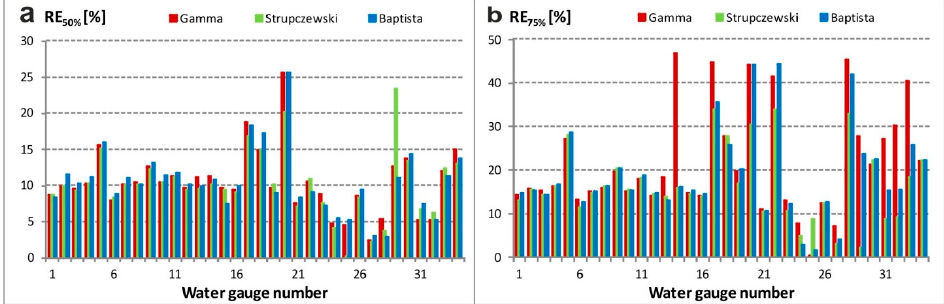
Figure 6. Relative errors of hydrograph width W p : ( a ) p = 50%, ( b ) p = 75%.